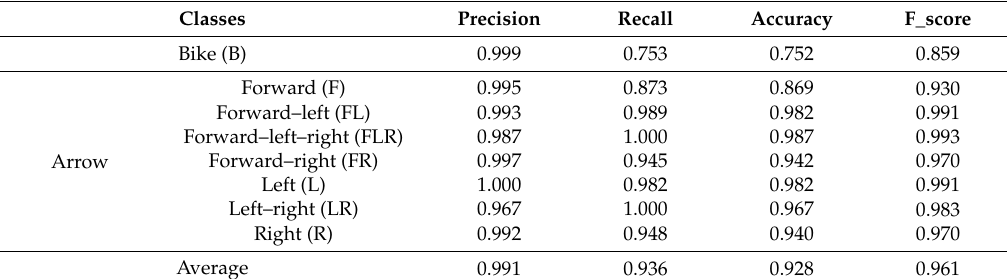
Table 6. Accuracies by our proposed method for different classes.